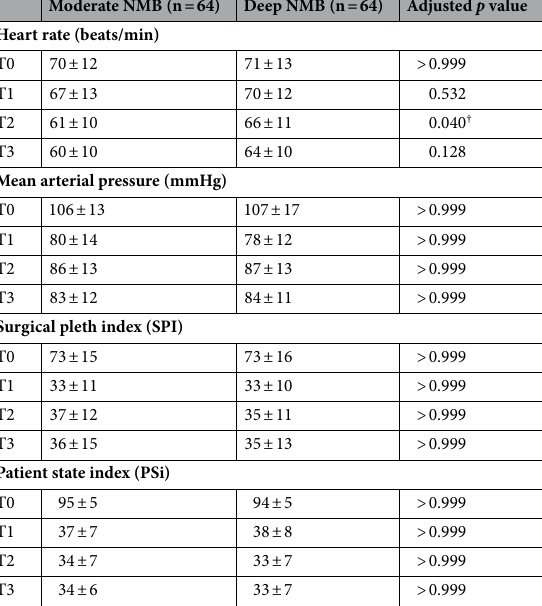
Moderate NMB (n = 64) Deep NMB (n = 64) Adjusted p